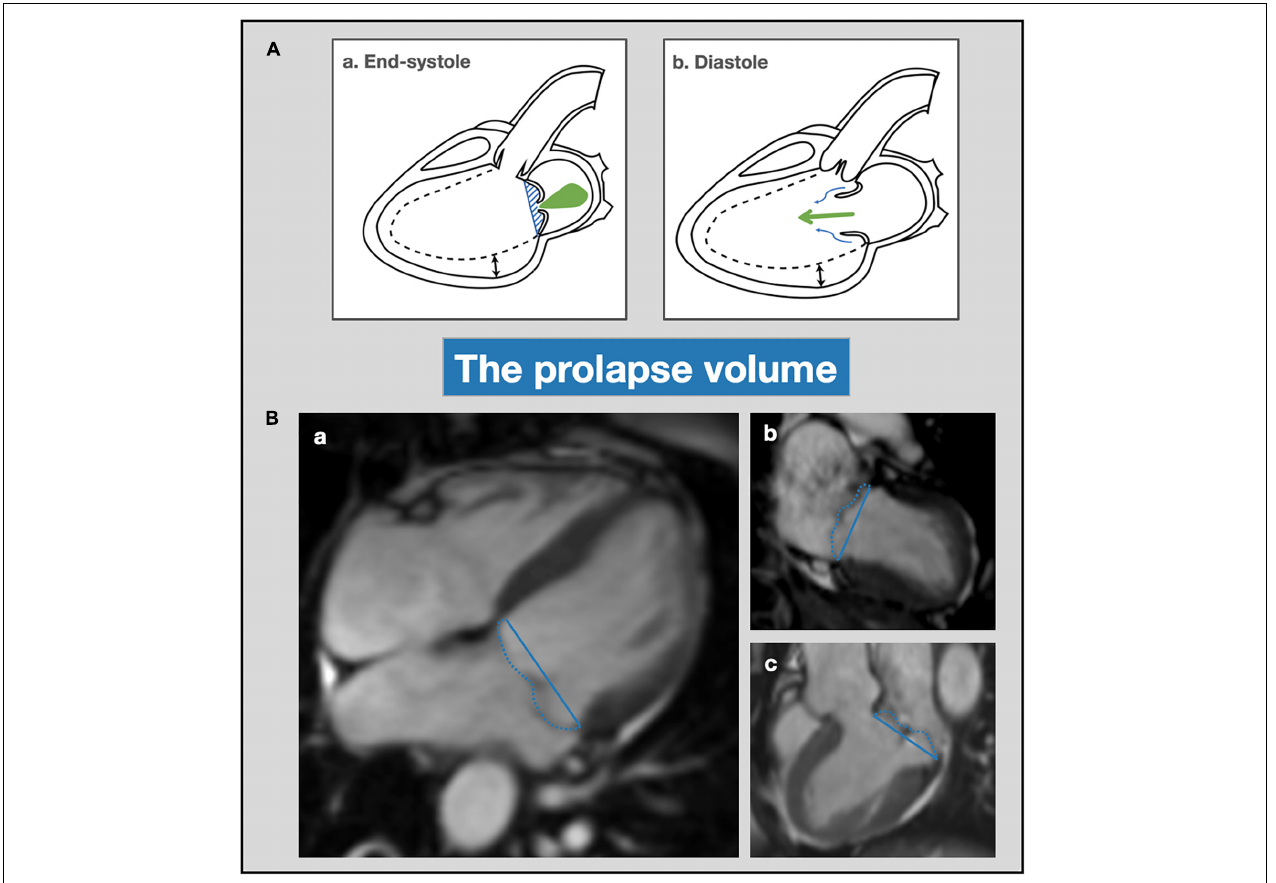
FIGURE 2 | Prolapse volume—mechanism and assessment with cardiac magnetic resonance imaging. (A) Schematic overview of prolapse volume as a mechanism for progressive LV remodeling (dotted line). In end-systole (a) transvalvular MR occurs (green jet) and the prolapse volume is contained beneath the mitral leaflets (blue shaded area) and delineated by the mitral annulus (blue line). In diastole (b) the prolapse volume (blue arrows) exerts an additional volume load on the left ventricle on top of the transvalvular MR volume (green arrows). (B) Mitral valve prolapse volume assessment with CMR. CMR cine images of patient with bileaflet mitral valve prolapse and mitral regurgitation; 4-chamber (a), 2-chamber (b) and 3-chamber (c) views. Calculation of the prolapse volume is performed as previously described (12, 26). First, the mitral valve annulus diameter is measured in each view (indicated with the blue line) in order to calculate the average mitral annulus diameter. Then, the end-systolic prolapse area is measured by tracing the area between the mitral valve leaflets and annulus in each view (dashed blue line). By dividing the prolapse area by the annulus diameters, the prolapse height can be calculated for each view. Finally, the prolapse volume can be determined by multiplying mean prolapse height with annulus area, which can be calculated using the ellipse area formula. LV, left ventricular; MR, mitral regurgitation; CMR, cardiac magnetic resonance